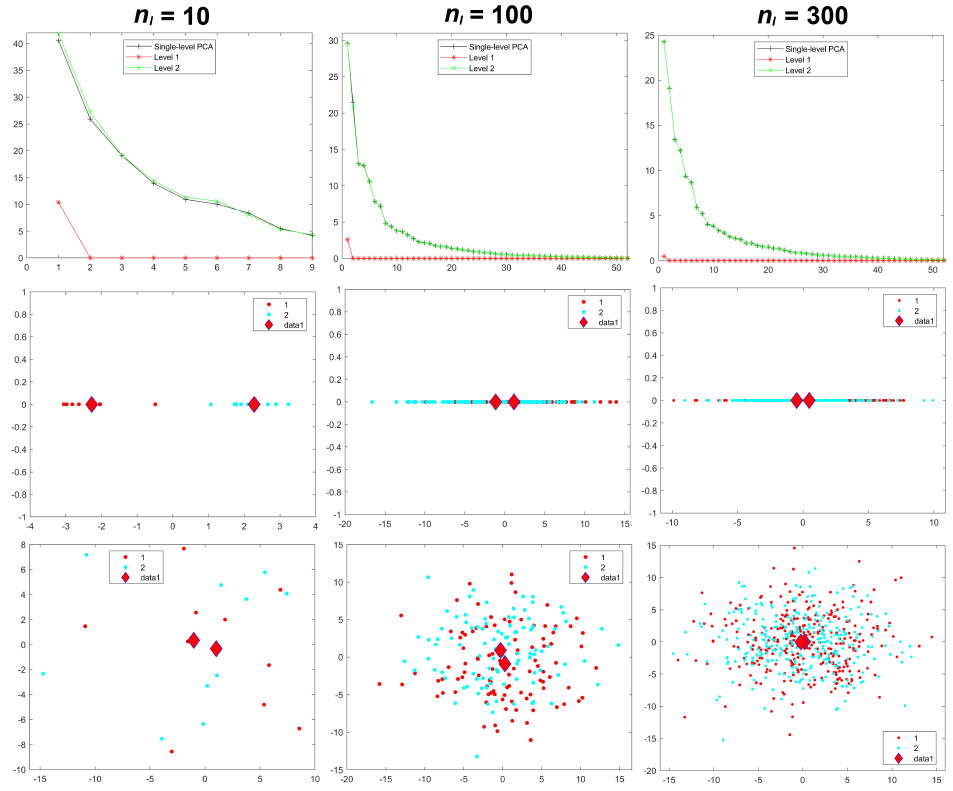
Figure 8. Experiment 4: eigenvalues ( upper row ), mPCA, level 1 component scores ( middle row ), and single-level PCA, component scores ( bottom row ) for sample sizes per group of n l = 10 ( left- hand column ), n l = 100 ( middle column ), and n l = 300 ( right-hand column ) in both groups l = 1,2. Group centroids are shown by the diamonds; x -axis = first component; y -axis = second